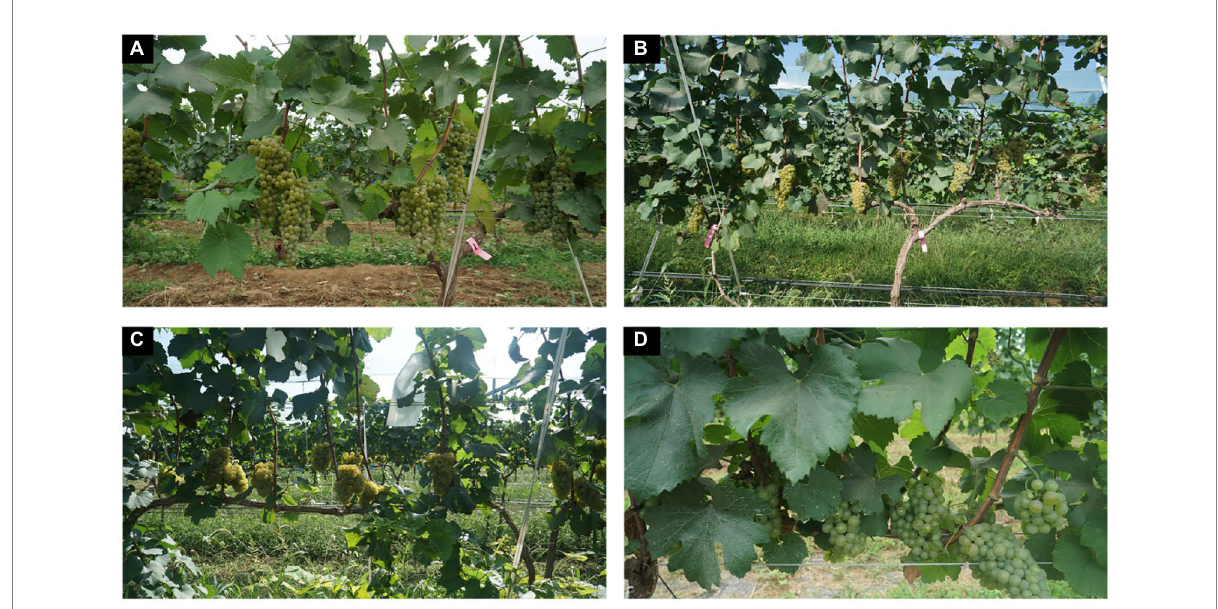
FIGURE 1 Examples of images acquired under different field sunlight conditions and distances. (A) Natural sunlight. (B) Smooth light. (C) Backlighting. (D) Distance changes